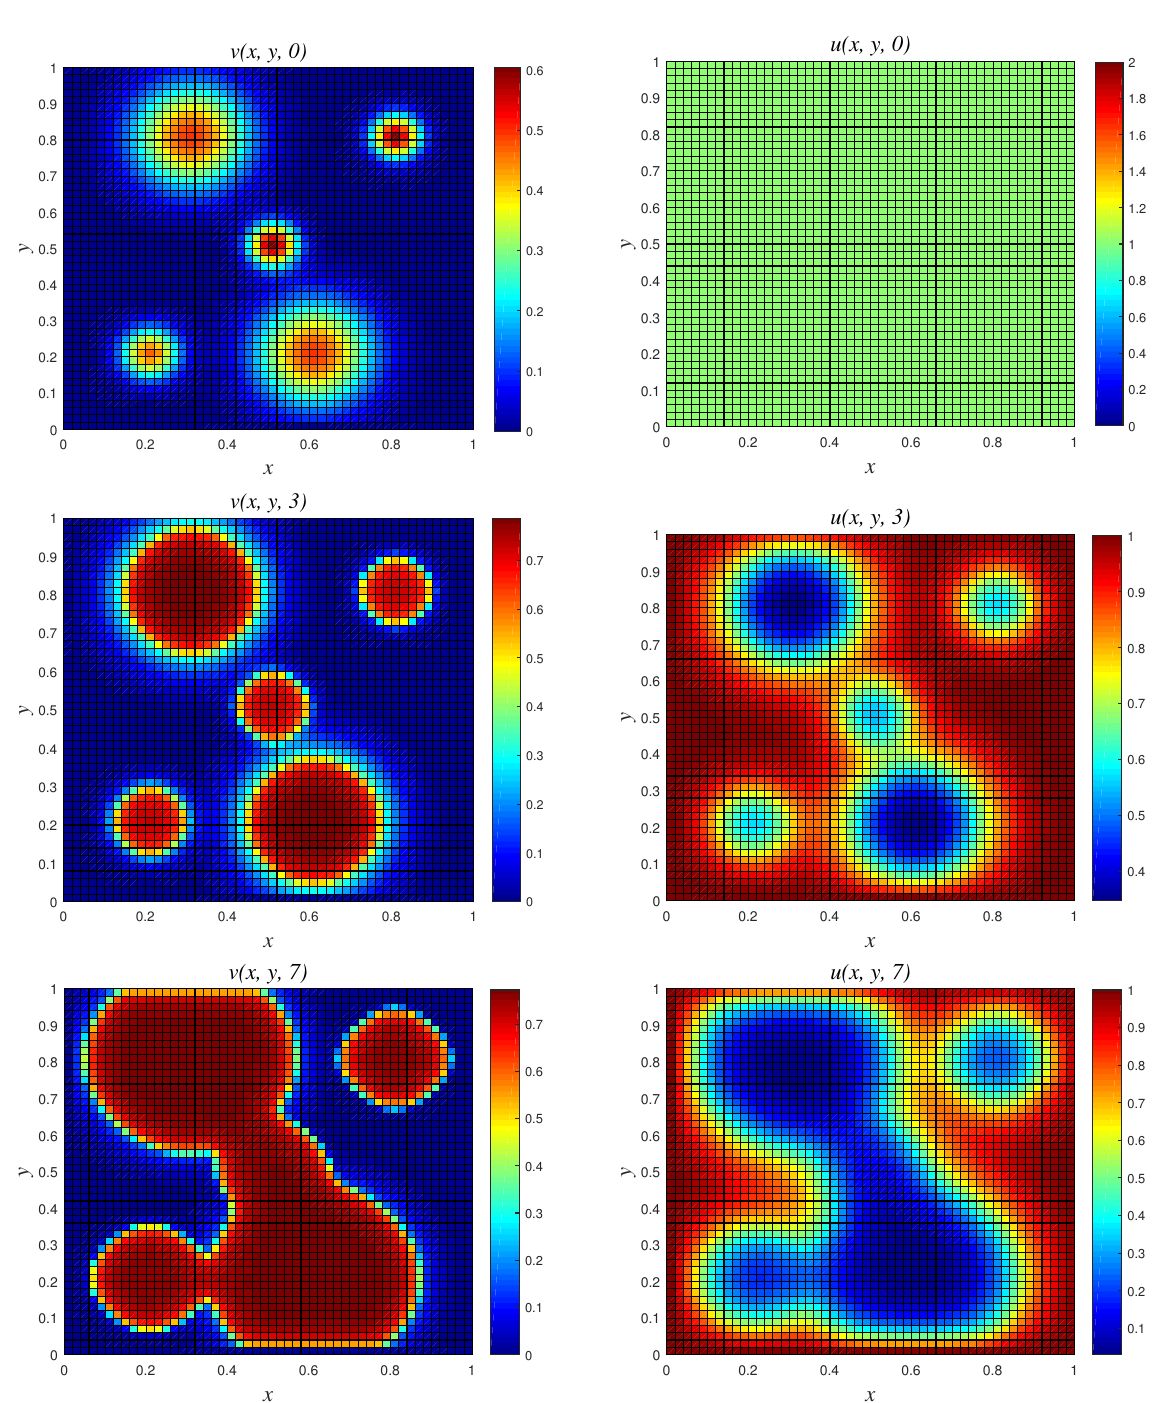
Figure 10. 3D plots of numerical solution vs. x vs. y using NSFD2 scheme at times t = 0,3 and 7. We used spatial step sizes h x = h y = 0.02 and time step k =